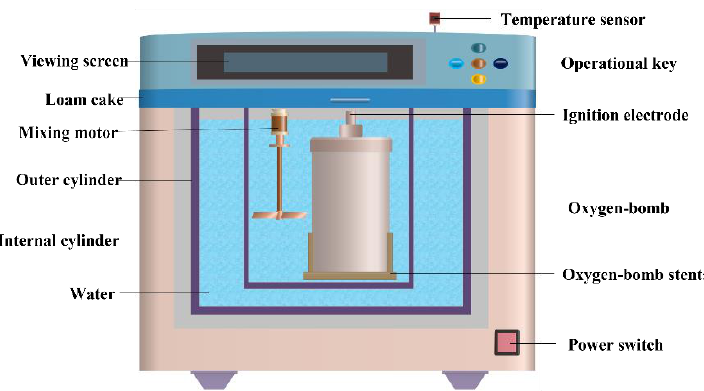
Figure 3. Structural diagram of automatic oxygen bomb calorimeter.